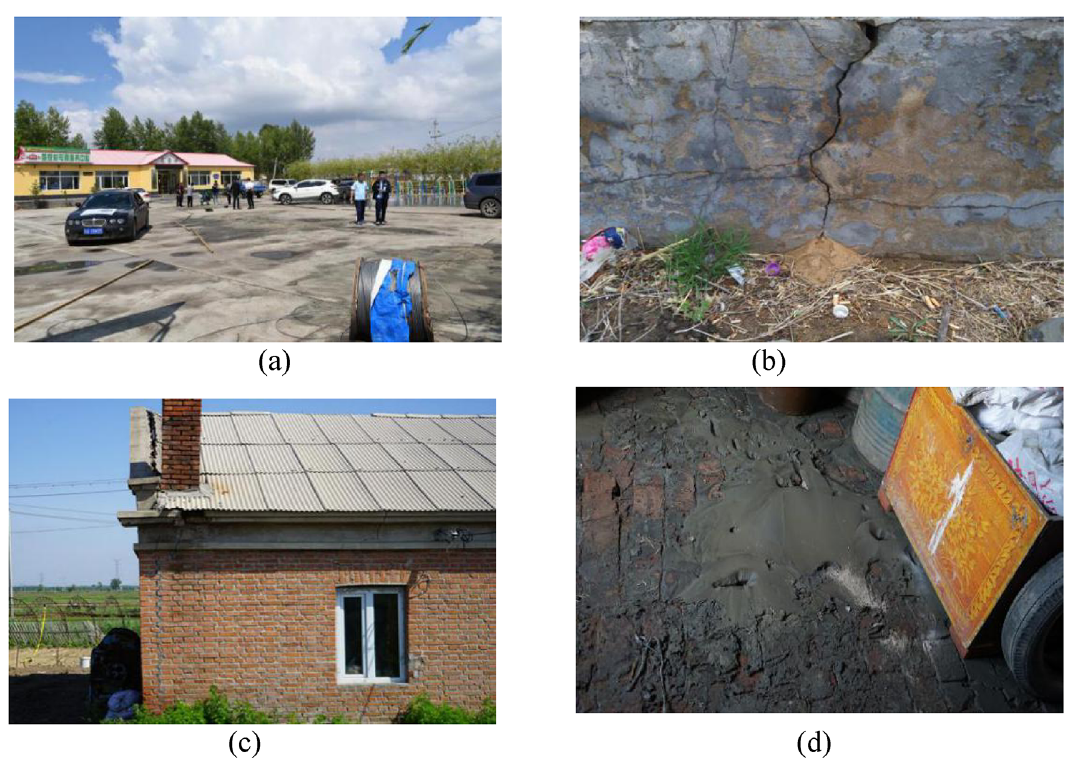
Figure 7. Construction damage due to liquefication: damage to a village committee office at Jiangjia ( a , b ) and damage to a house in Cuijia ( c , d diameter of most concentric shape was greater than 1 m and the largest recorded diameter was 10 m. The volume of the ejecta was approximately 10 m 3 . On the other hand, the string beads shape was embodied as a combination of multiple concentric shape, with the maximum length exceeded 20 m. The diameter of liquefied hole ranged from 20 cm to 4 m, with the maximum depth of 4 m. There are two main types of the liquefied sand ejected in this earthquake: yellow fine sand and gray fine sand. The yellow fine sand is more widely distributed than the gray fine sand, which mainly includes quartz and feldspar. The buried depth is about 3-7 m below the surface. The gray fine sand contains a certain amount of mica. The buried depth is generally greater than 5 m. The yellow fine sand is covered by the gray fine sand in part of the liquefied sites, this phenomenon is consistent with the buried relationship between the two types of sand. The particle size distribution of the two types liquefied sand are presented in Fig. 6. It is worth noting that samples are taken from the surface, not underground. Despite the appearance of liquefaction macrophenomena, there was no extensive damage to building caused by the liquefaction. There were only two observed occasion on liquefaction-related damage to building: the damage to a village committee office at Jiangjia (Fig. 7a,b) and the damage to a house in Cuijia (Fig. 7c,d). These